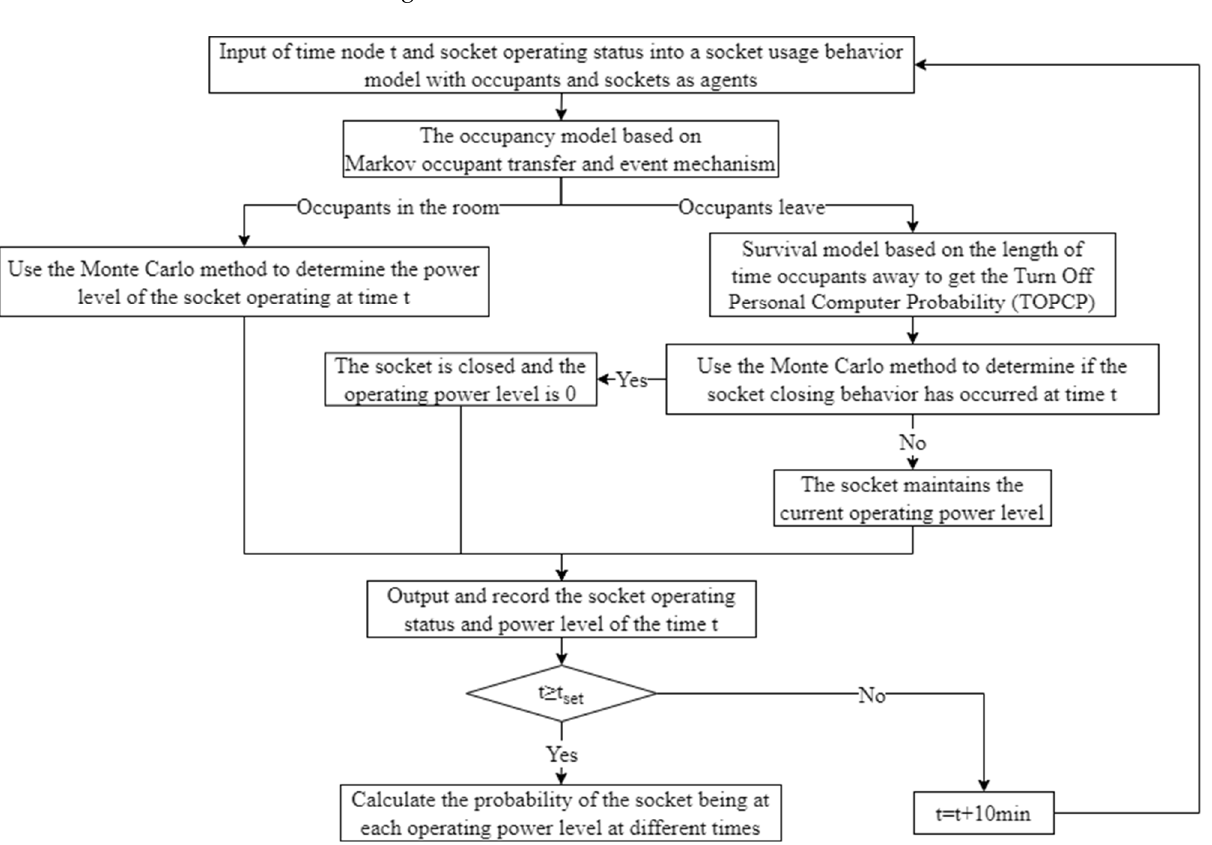
Figure 2. The modeling process and internal operation rules of agent-based socket usage